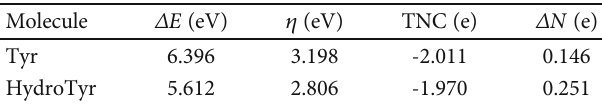
Table 8: Some relevant electronic structure parameters of Tyr and HydroTyr